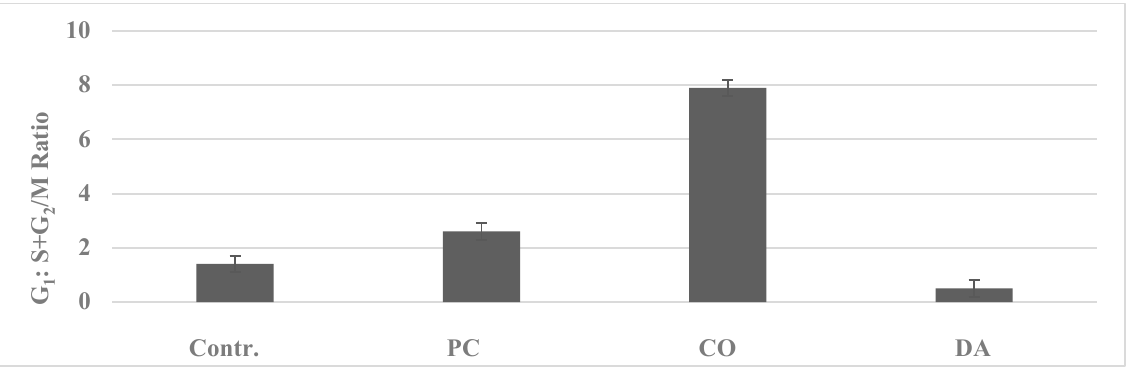
Figure 1. Effect of Chinese herbs on cell cycle progression. Treatment with PC and CO at their respective IC 90 doses increased the ratio, while treatment with DA at IC 90 dose reduced the ratio. The data are presented as G 1 : S + G 2 /M ratio mean ± SD, n = 3 per treatment group, and analyzed by ANOVA with Dunnett’s multiple comparison test ( α = 0.05). Contr., control; PC, Psoralea corylifolia ; CO, Cornus officinalis. SD, standard deviation; ANOVA, analysis of variance. Data summarized from [14–16].